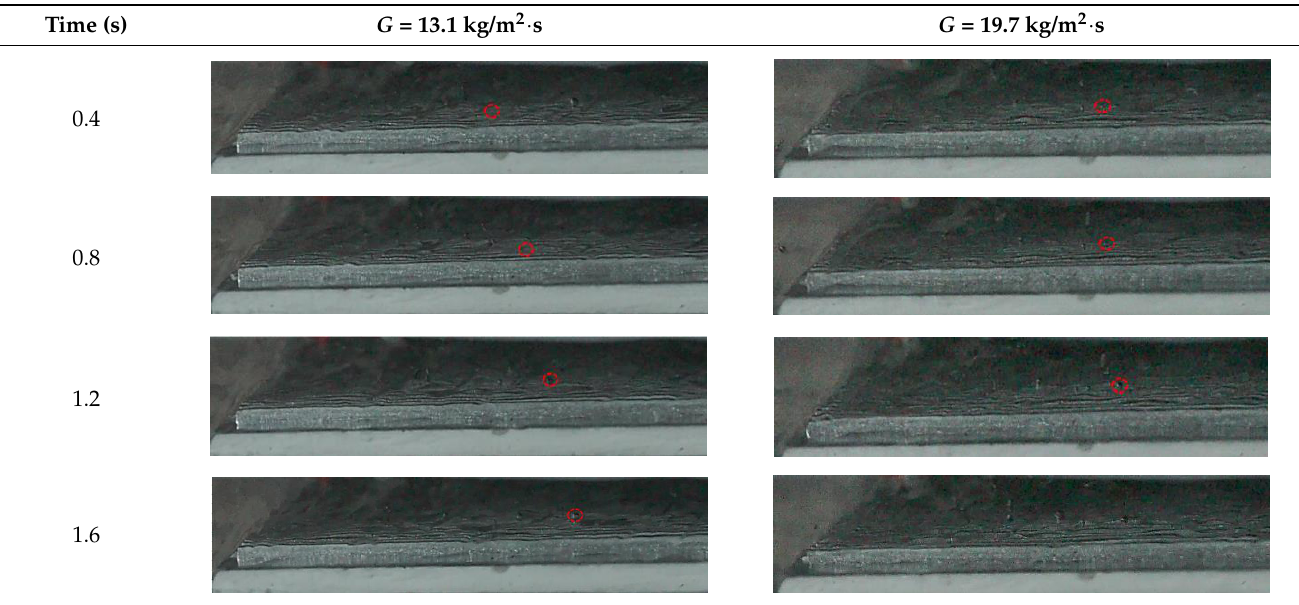
Table 4. Bubble (indicated by red dotted circles) lift-off mechanism in the R1 test case and input power of 170 W.